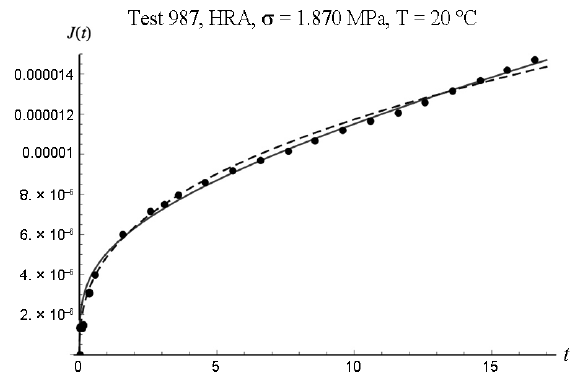
Fig. 4. HRA Experimental data (dots) contrasted with best- fitting curves of the proposed model (continuous line) and the Scott-Blair model (dashed line), 20 °C